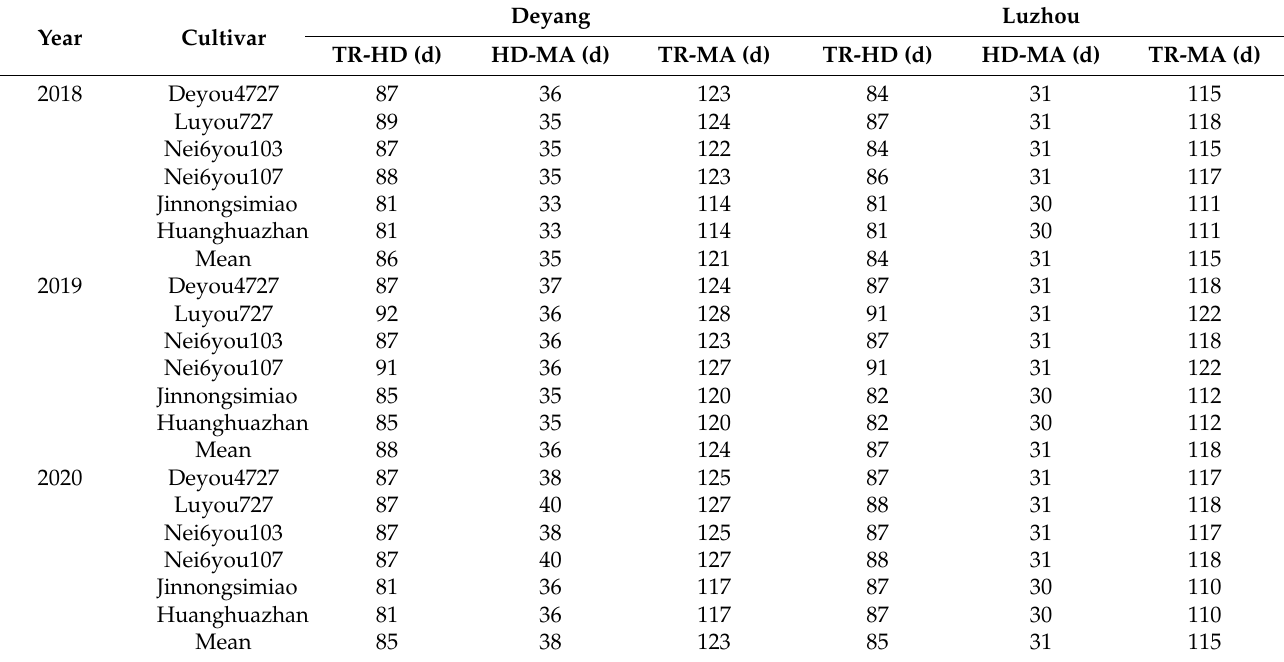
Table 2. Growth duration of six rice cultivars grown in Deyang and Luzhou, Sichuan Province, China, from 2018 to